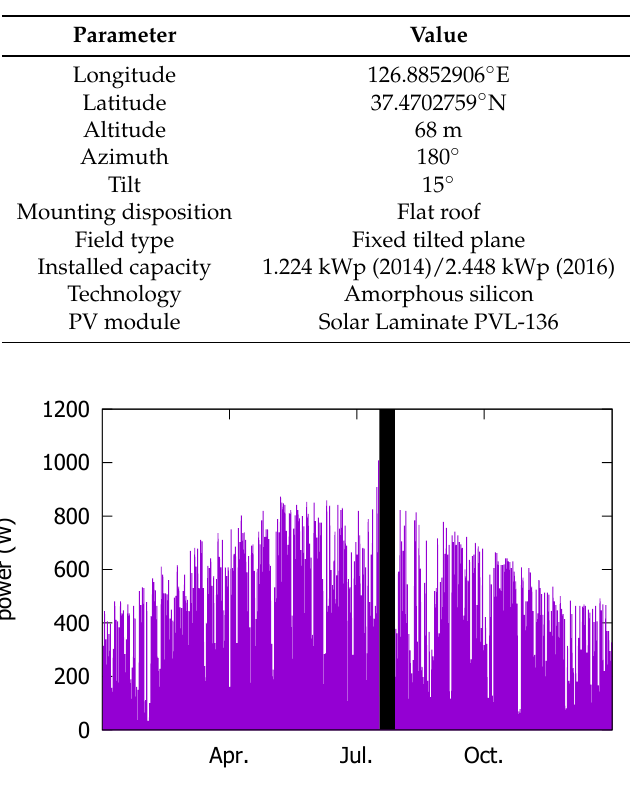
Figure 6. Actual PV power output in